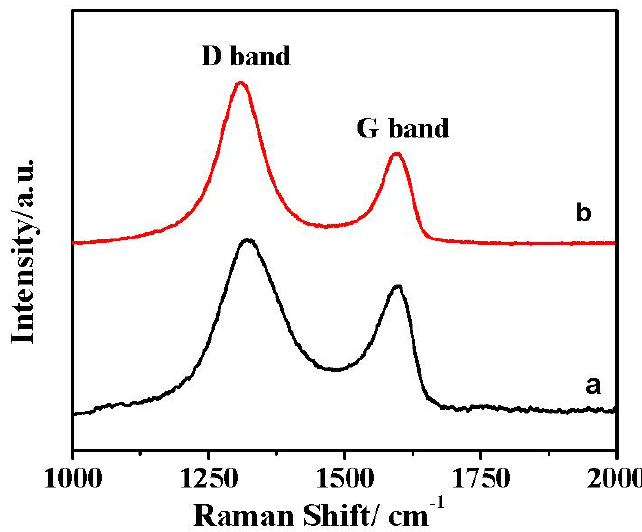
Figure 4. Raman spectra of different samples: ( a ) GO; ( b ) PMo 12